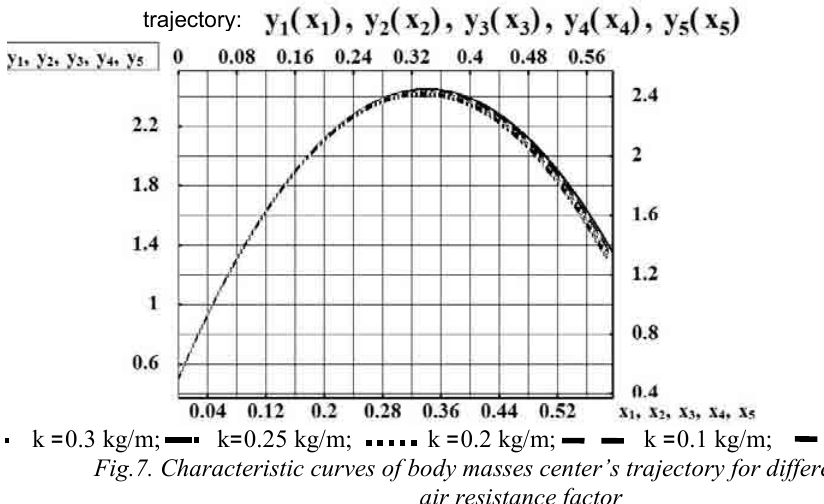
Fig.7. Characteristic curves of body masses center’s trajectory for different values of air resistance factor